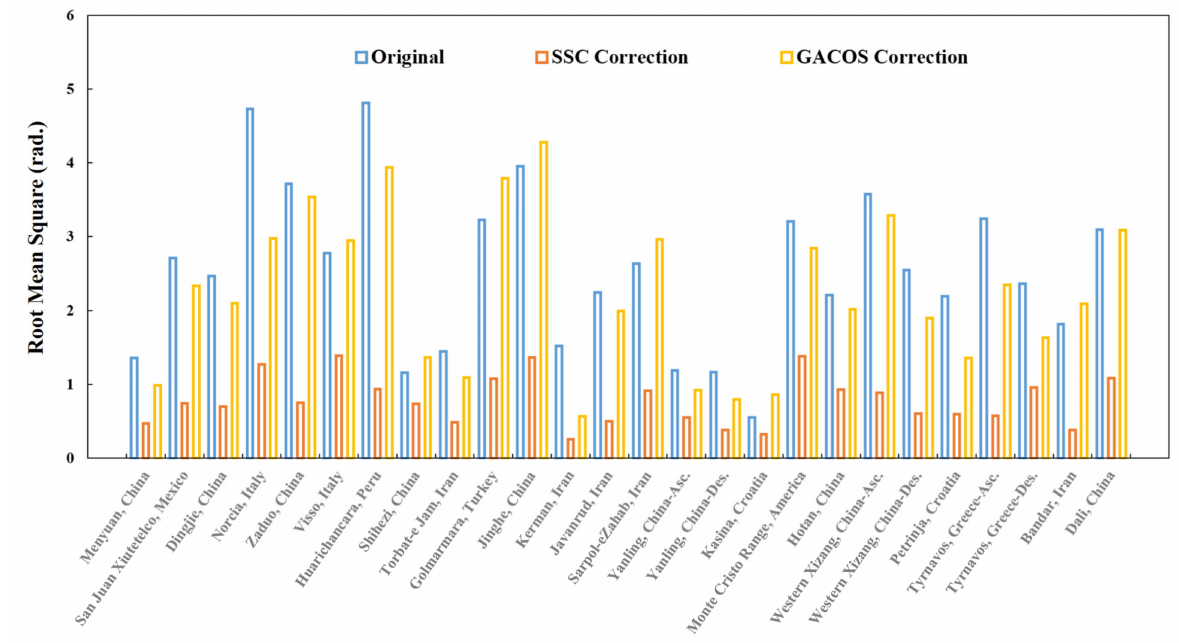
Figure 4. Statistics before and after correction. The Y -axis denotes the RMS value of each case with a unit of radiance. The blue bars denote the image RMS before correction. The red bars denote the image RMS after applying the method developed here. The yellow bars denote the image RMS after correction by GACOS